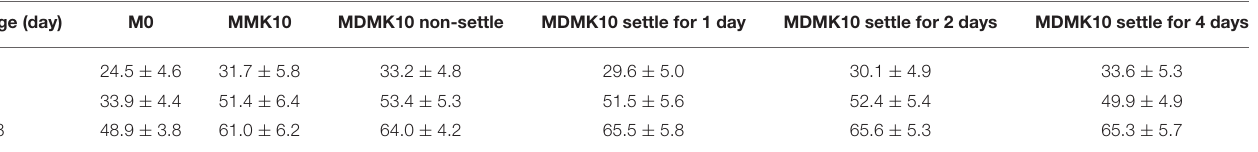
TABLE 6 | Compressive strength of mortar specimens